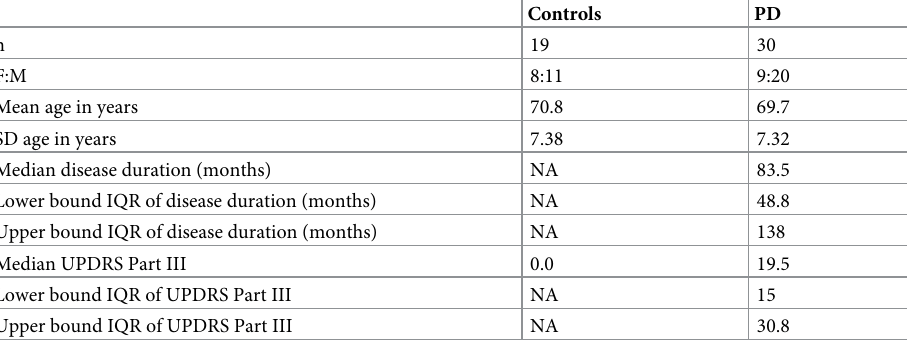
Table 1. Demographic